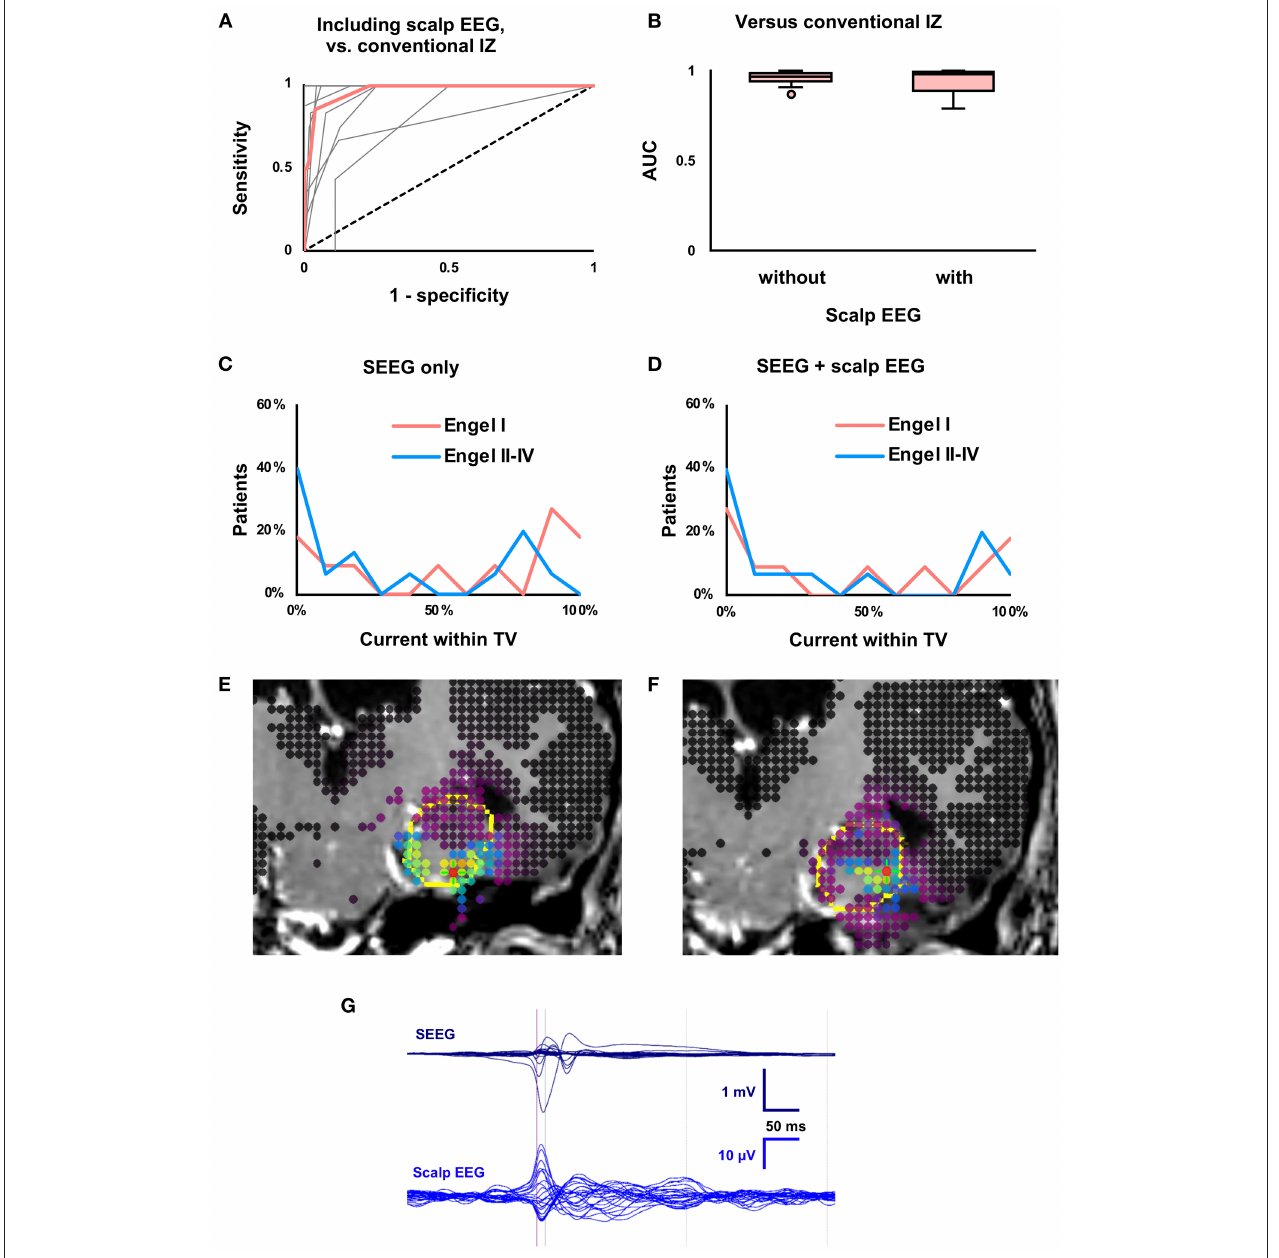
FIGURE 4 | Effects of including concurrent scalp EEG. (A) Receiver-operating characteristic (ROC) curve for concordance of the conventional and modeled irritative zones (IZ) when scalp EEG was included. Median (thick red line) and individual patient curves (thin gray lines) are shown. (B) Boxplot of ROC area under the curve (AUC), which was not affected ( P = 0.38) by inclusion of scalp EEG. (C) Using SEEG, the proportion of current within the treatment volume (TV) predicted seizure outcome, as in Figure 2A . (D) Percent overlap of the modeled IZ with the TV was unable to predict seizure outcome ( P = 0.23) when concurrent scalp EEG was also analyzed. (E) SEEG-derived current density map (as in Figure 3 ) from patient with previously resected temporal pleomorphic xanthoastrocytoma with Engel I outcome after laser ablation of amygdala and hippocampus. (F) Current density map derived from both SEEG and scalp EEG in the same patient. Note the lateral shift in the modeled IZ. (G) Butterfly plot of averaged interictal epileptiform discharges on SEEG and concurrent scalp EEG from the same patient. The time point used for source localization (half-rise point in SEEG) is indicated by the purple vertical line.